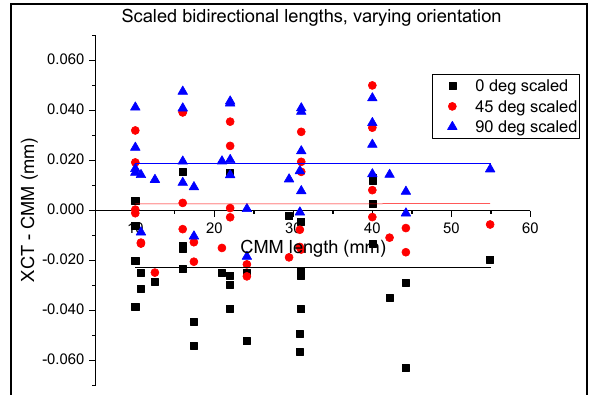
Figure 11: Slope and standard deviation for deviation in bidirectional lengths taken at 1.6 times magnification Again the results were corrected for the scaling error, the results can be seen in Figure 12.